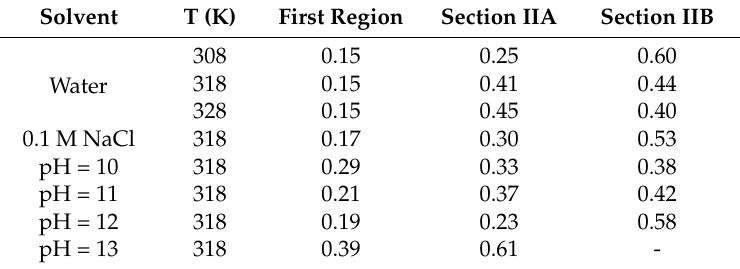
Table 4. Relative magnitude of region I and sections IIA and IIB for adsorption of CR on GO/PAMAM in water, 0.1 M NaCl, and alkaline solutions at 308–328